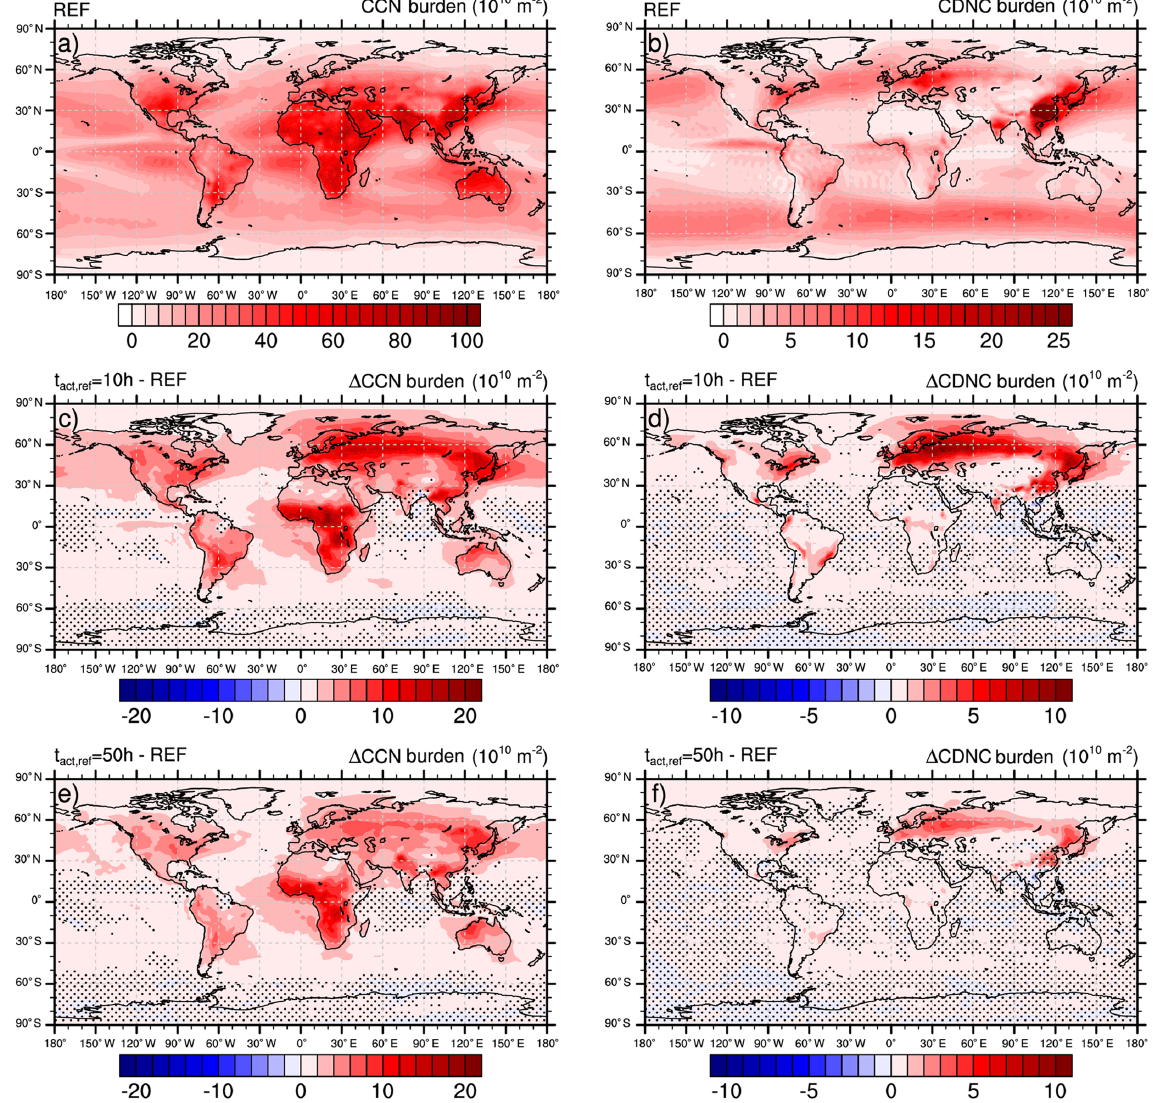
Figure 4. 20-year mean vertically integrated burden of cloud condensation nuclei (CCN; a , c , e ) and cloud droplet number concentration (CDNC; b , d , f ), respectively) of the reference simulation (REF; a , b ) and the change due to heterogeneous O 3 oxidation of soot particles for two reference activation times t act , ref = 10h (c, d) and t act , ref = 50h (e, f) . Blue colors indicate a reduction and red colors indicate an increase in the respective parameter. Note that, for better perceptibility of the important features, hatching indicates statistically non- significant differences ( <